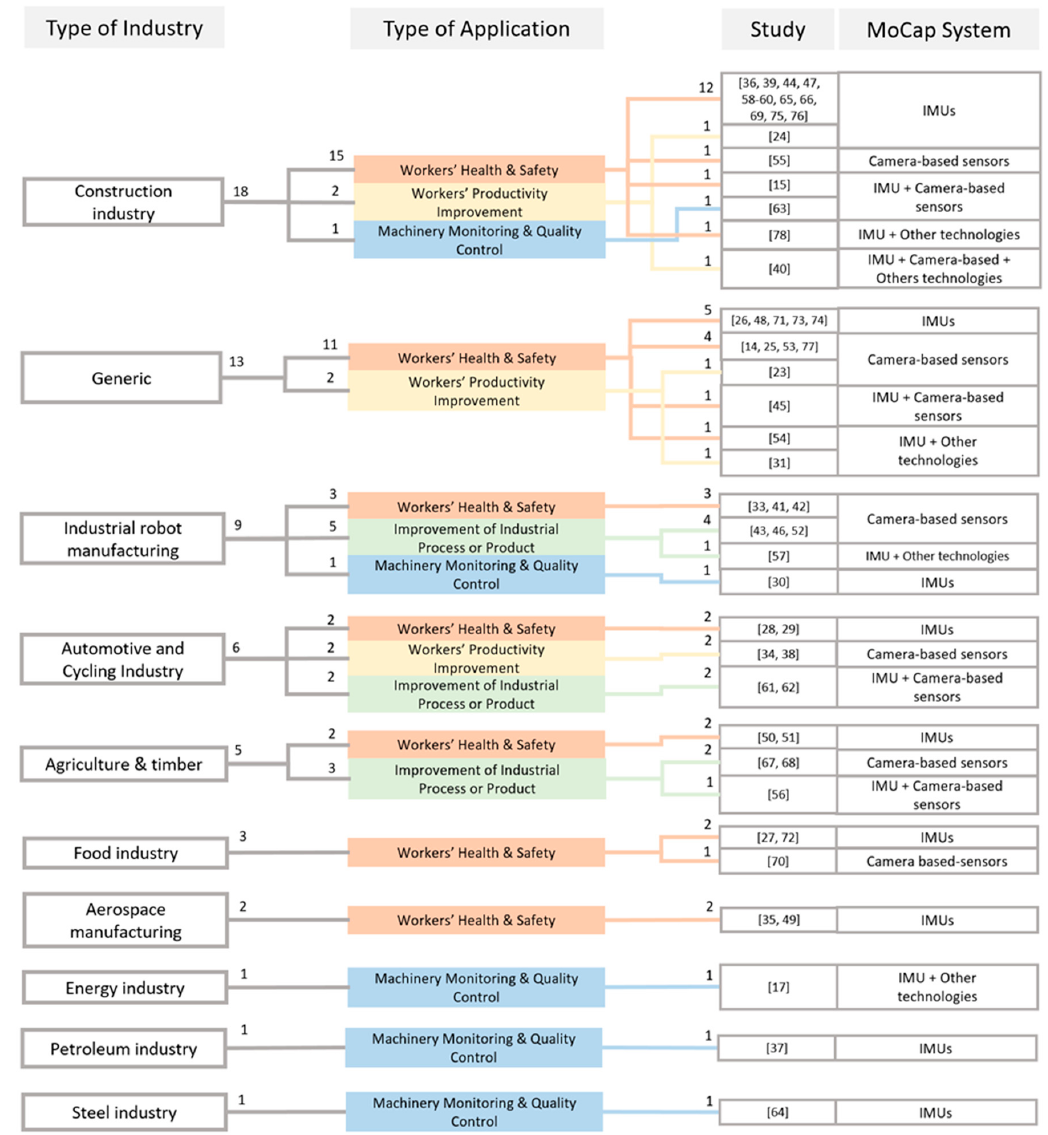
Figure 5. The relations between type of industry, application and MoCap system, for each considered study. Indexes at the top of each branch specify the number of studies associated to each block.